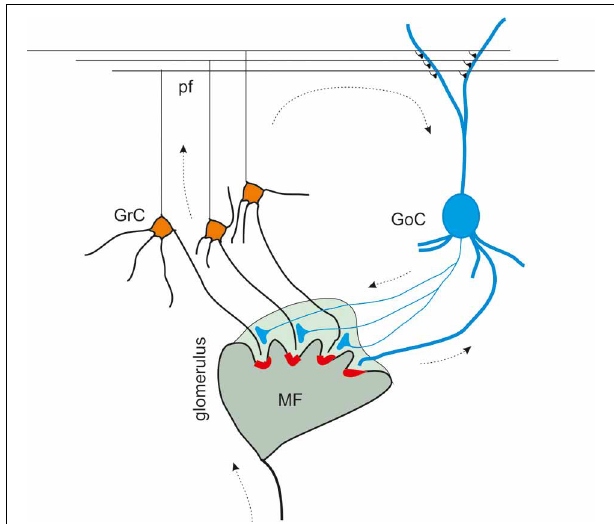
FIGURE 1 | The inhibitory circuit of cerebellar granular layer. In the granular layer of the cerebellar cortex, granule cells receive excitatory inputs from the mossy fibers and are inhibited by Golgi cells. The synaptic contacts among granule cell (GrC) dendrites, mossy fiber (MF) terminals, and Golgi cell (GoC) axon and dendrites are enwrapped into a glial sheet, originating a peculiar anatomical structure known as cerebellar glomerulus. Each glomerulus is characterized by one mossy fiber rosette and several granule cell and Golgi cell dendrites, as well as Golgi cell axons. Each granule cell dendrite contacts different glomeruli, receiving inputs from different mossy fibers. GrC axon ascends in the molecular layer, where it originates the parallel fibers (pf), that form excitatory synapses on GoC dendrites (Palkovits et al., 1971; Palay and Chan-Palay, 1974; Hámori and Somogyi, 1983). Mossy fiber terminals contact granule cell dendrites as well as Golgi cells, that therefore inhibit granule cells in a feedforward loop. Parallel fibers originating from granule cell axons, activates Golgi cells, giving rise to a feedback inhibition on granule